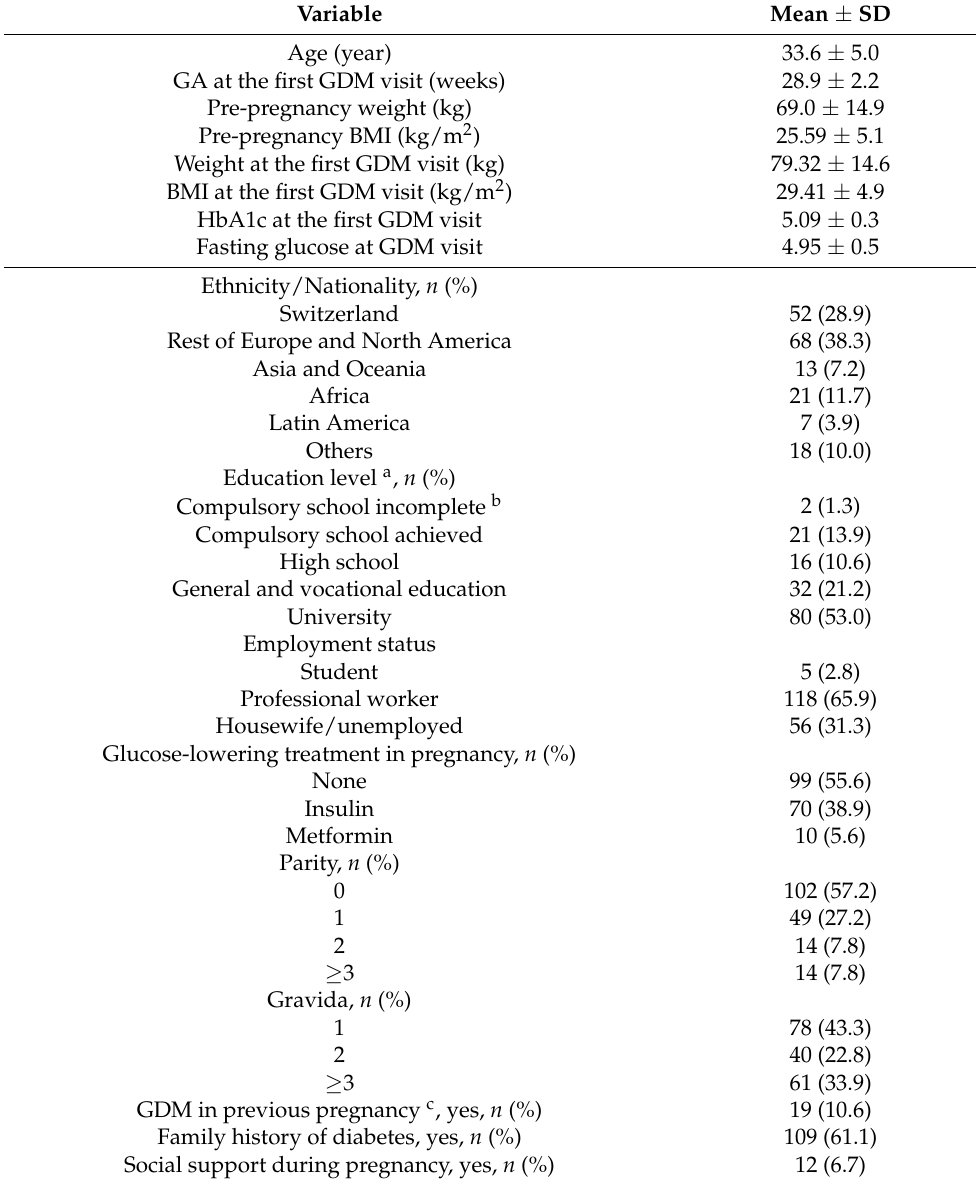
Table 1. Baseline maternal socio-demographic and health characteristics ( n =